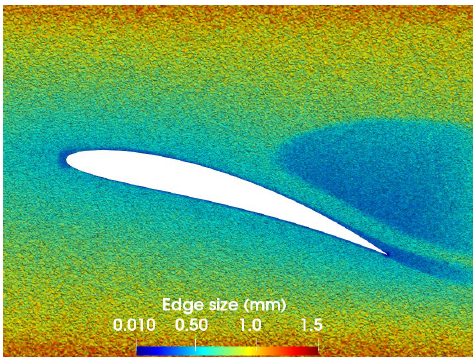
Figure 9. Adapted mesh at z /c =